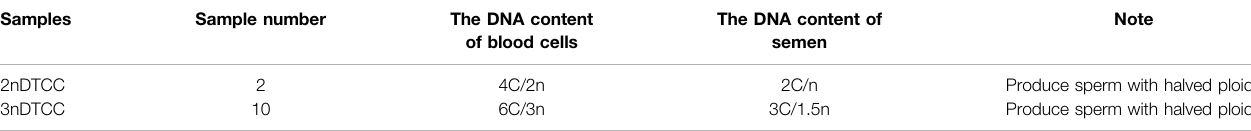
TABLE 1 | The DNA content of semen collected from 2nDTCC and